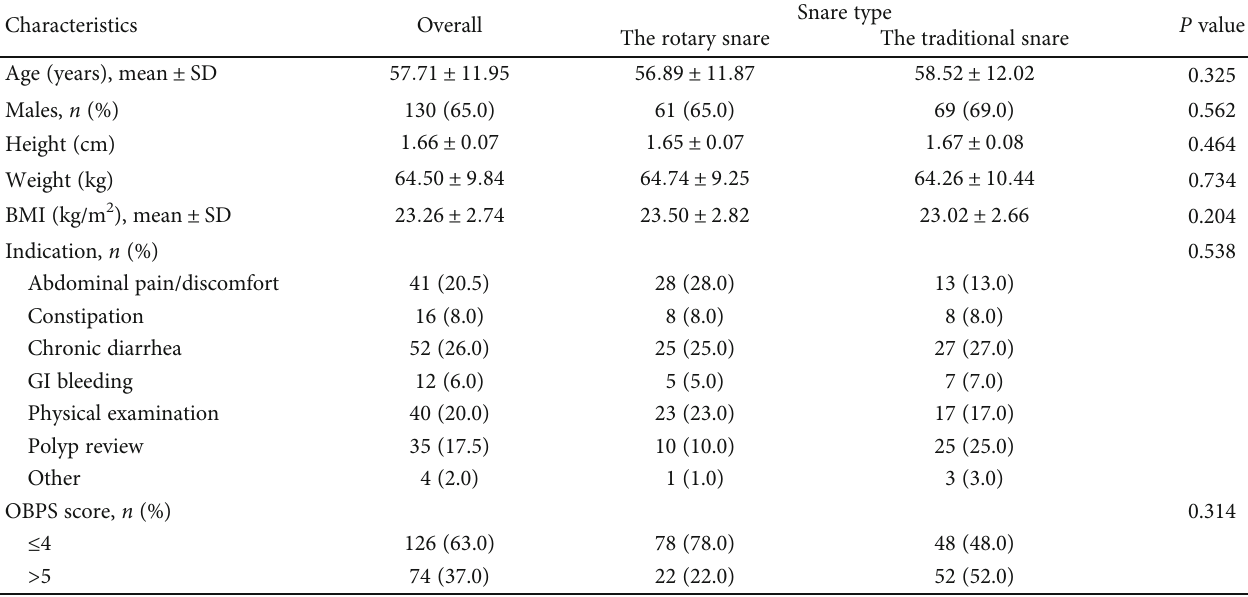
Table 1: The characteristics of the included participants.